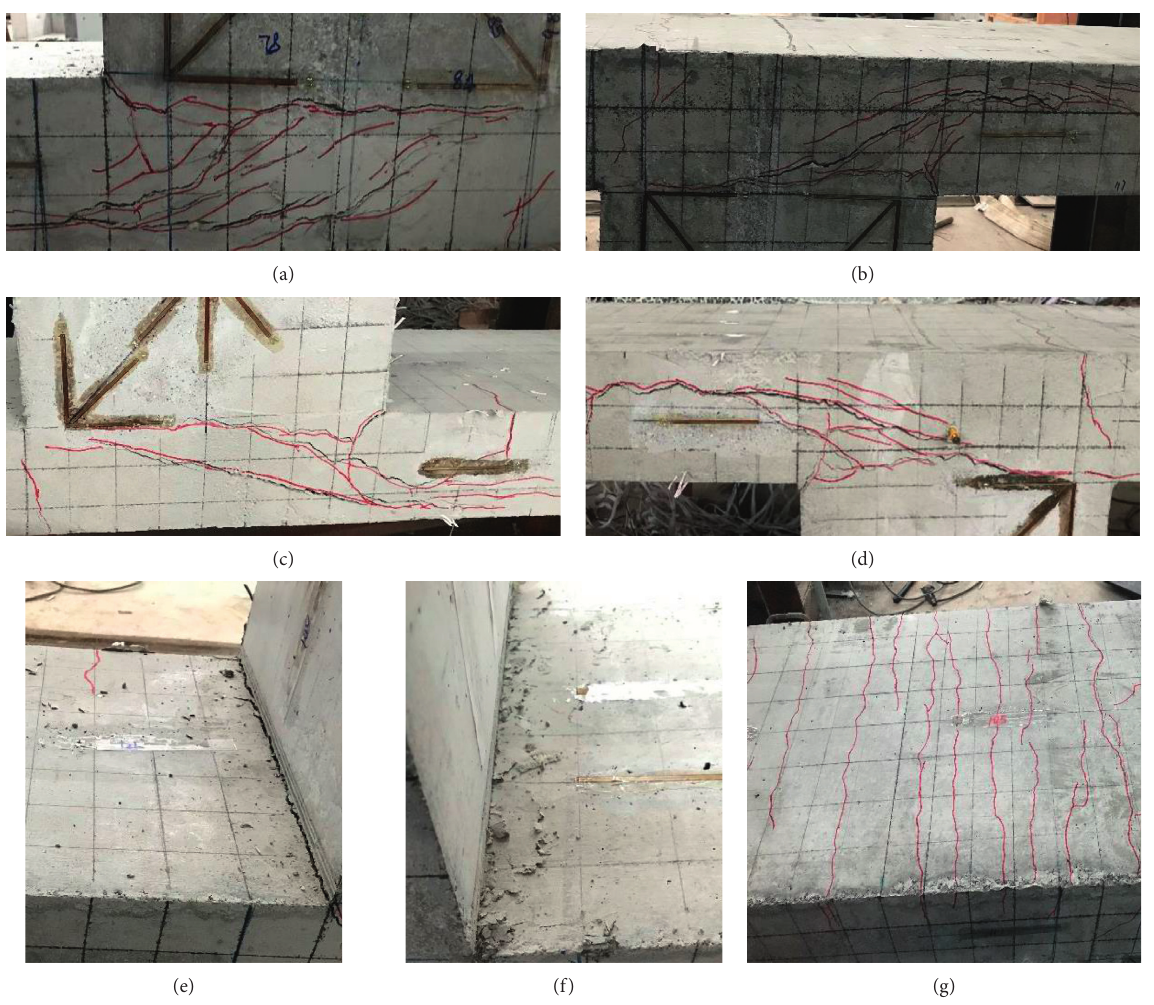
Figure 13: The failure form diagram. The cracks at the location where the shear key on the front of the test piece connects with the (a) bottom chord and (b) top chord. The cracks at the location where the shear key on the back of the test piece connects with the (c) bottom chord and (d) top chord. (e) The location where the left side of shear key connects with bottom chords is pulled apart. (f) The location where the right side of shear key connects with bottom chords is crushed. (g) The cracks at the location of the upper surface of the top